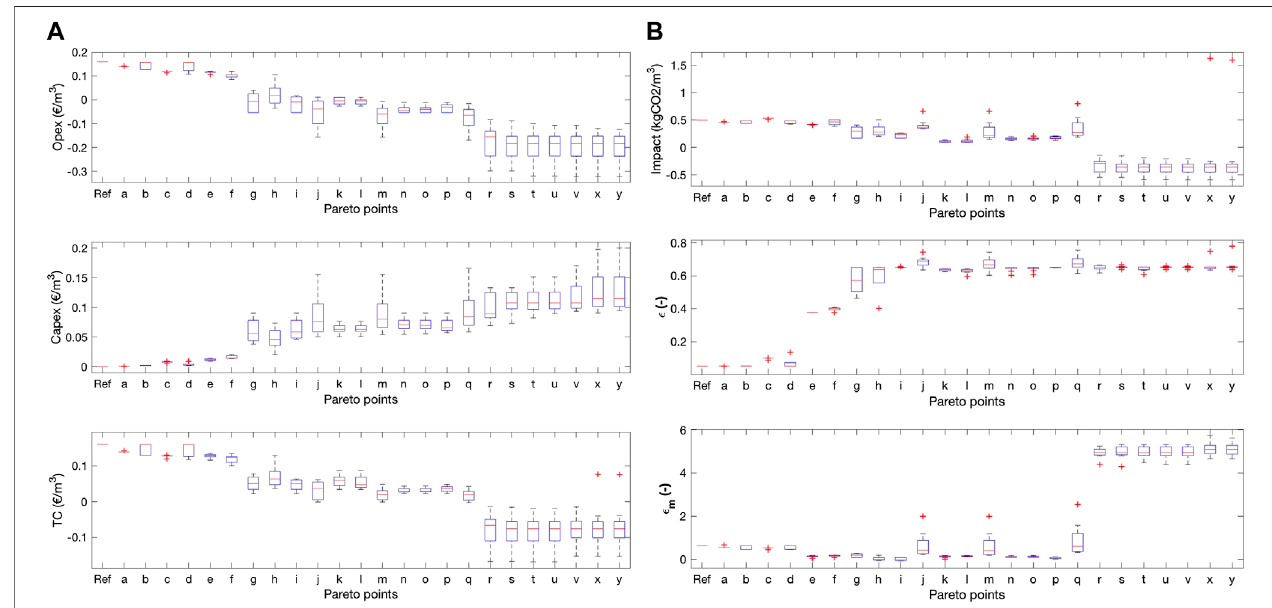
FIGURE 7 | Box plots for parametric analysis on inlet wastewater fl ow: (A) economic key performance indicators, (B) impact and ef fi ciencies key performance indicators.